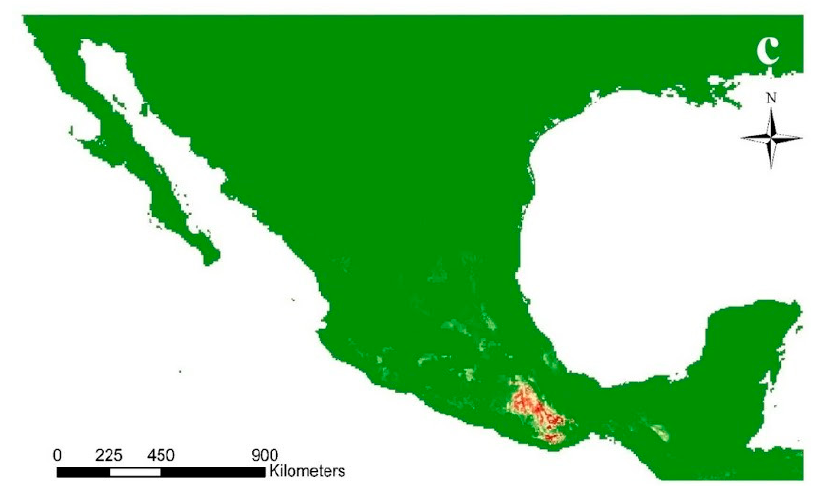
Figure 4. Distribution of suitable habitats of Mesoamerican Cypripedium based on the most reliable Maxent model. Rasters generated in Maxent [27]. Maps were generated in ArcGIS© 10.5 (ESRI, https://www.esri.com/en-us/home (accessed on 1 April 2022)) ( a ) C. dickinsonianum , ( b ) C. irapeanum , and ( c ) C. molle .